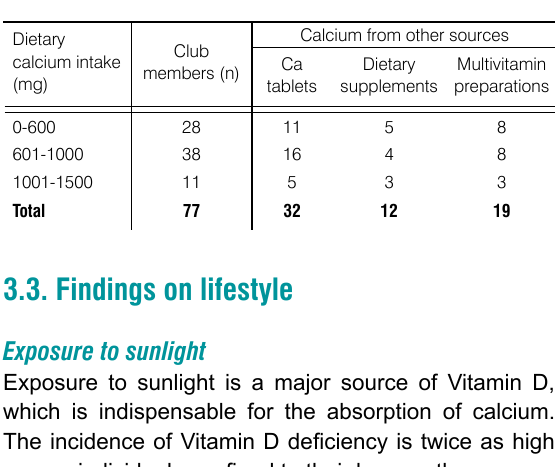
Table 1. Forms and sources of calcium